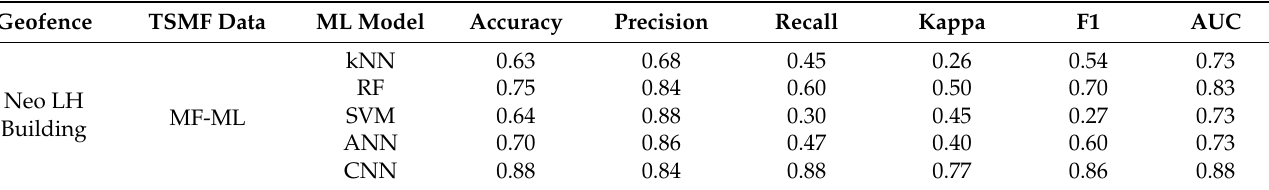
Table 4. Neo LH building outdoor MF-ML